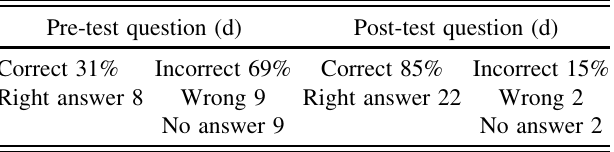
TABLE III. Correctness percentage of 26 students answering question (d) in the pre-test and post-test. Students who did not provide the correct response either provided wrong answers or left the question blank (which are represented by the items ‘‘wrong’’ and ‘‘no answer’’). The number corresponding to each item stands for the number of students giving a particular type of